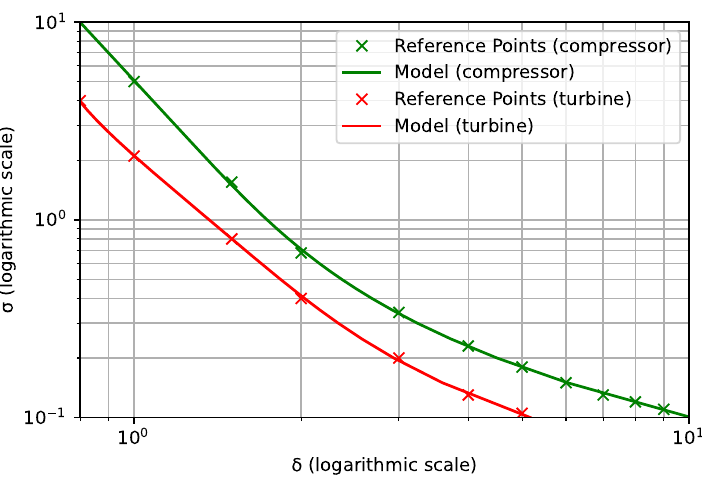
Figure 12. Cordier diagram with models and reference